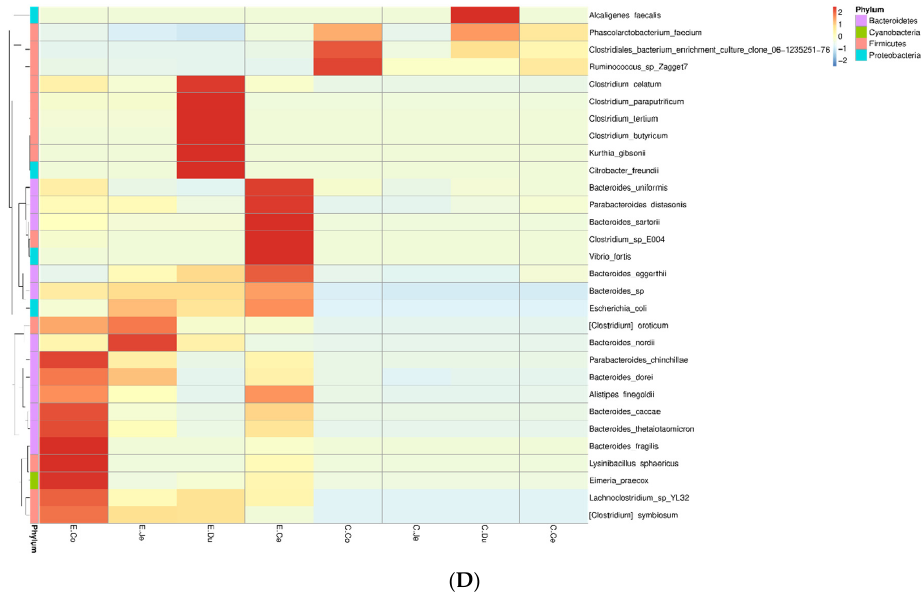
Figure 5. The relative abundances of dominant bacteria in the FIS of the Con ( n = 6) and Dia ( n = 6). ( A ) The top ten most abundant species at the phylum taxonomic level of each sample generated as a columnar cumulative plot of relative abundance of species. ( B ) The top 20 species with the highest abundance at the genus taxonomic level in each group generated as a columnar cumulative plot of relative abundance. ( C ) Heat maps of relative abundances of the top 20 dominant bacteria genera with the highest intestinal richness in Hyplus rabbit. ( D ) Heat maps of relative abundances of the top 30 dominant bacteria species with the highest intestinal richness in Hyplus rabbit. C, control group (Con, n = 6); E, diarrhea group (Dia, n = 6); Co, colon; Ce, cecum; Du, duodenum; Je, jejunum.